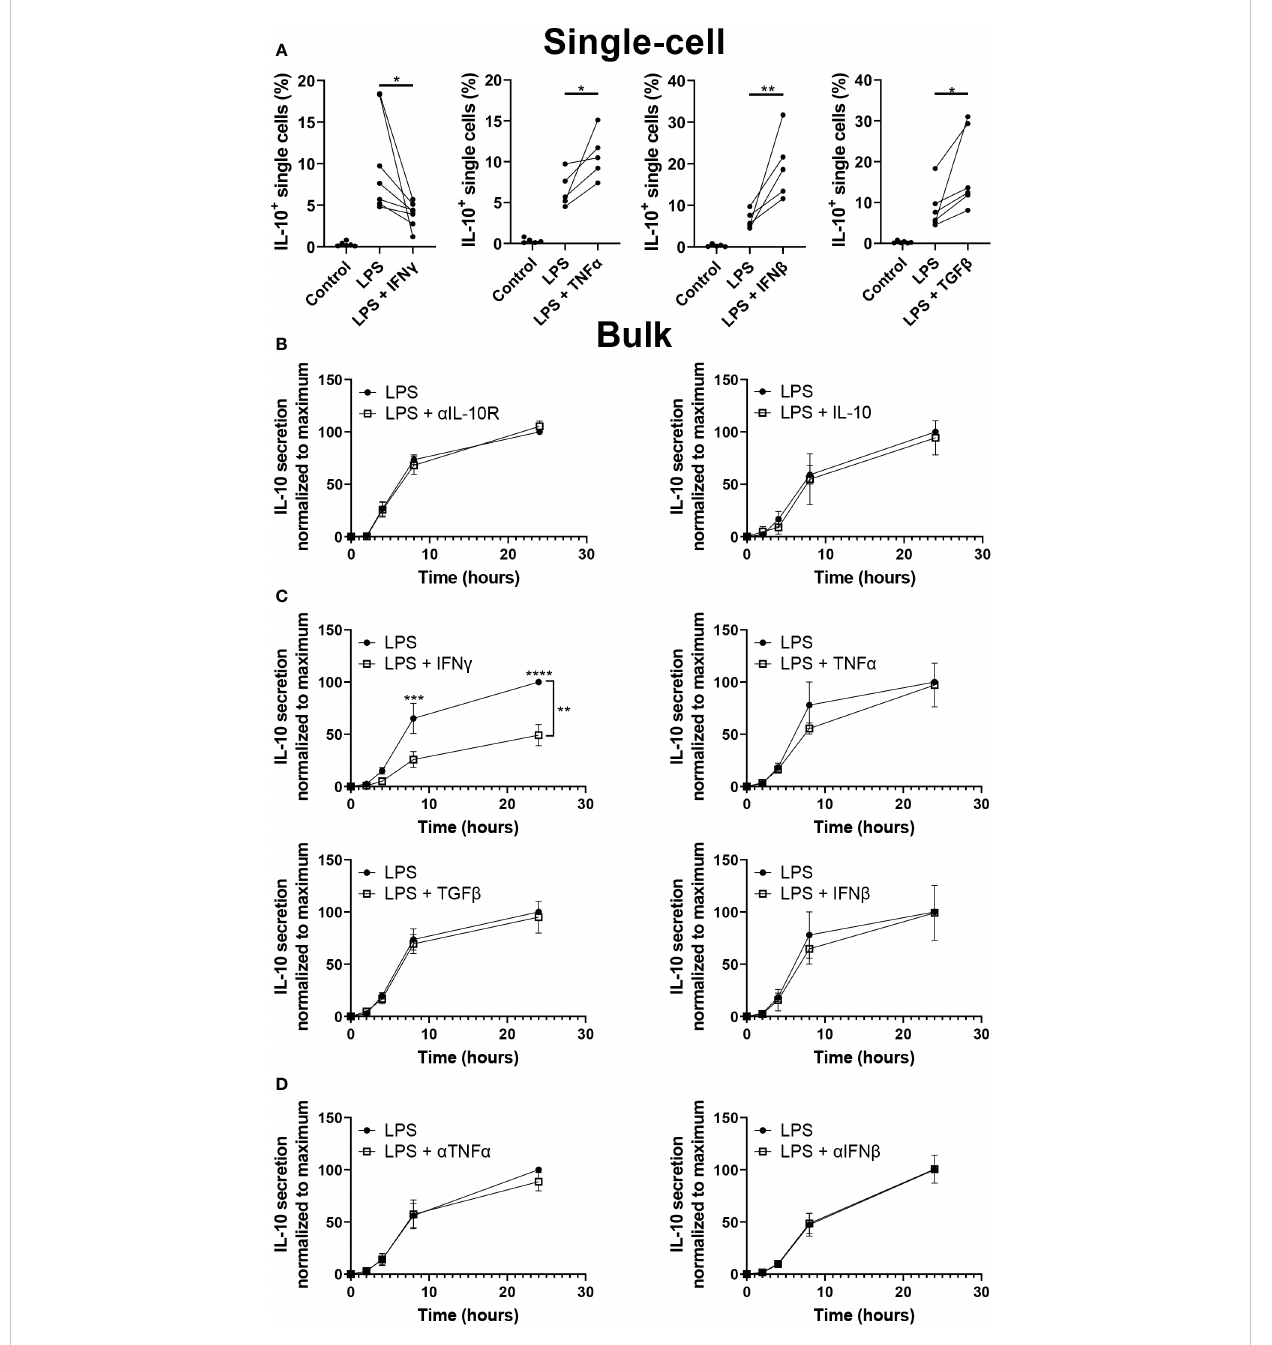
FIGURE 4 Effect of paracrine signals on IL-10 production. (A) Percentage of cells producing IL-10 after single-cell stimulation with LPS with or without IFNy (n=7), IFN b (n=5), TNF a (n =5) or TGF b (n=6). Signi fi cance was tested using One-way ANOVA and Tukey post hoc test. With * indicating p<0.05, and ** indicating p<0.01 (B) IL-10 quanti fi cation over 24h for bulk activated macrophages with and without IL-10R blocking antibodies (n=5 biological replicates) and with and without 100 pg IL-10 added 30 minutes prior to LPS activation. In the condition with IL-10 added, 100 pg of IL-10 was subtracted from fi nal readout (n=3 biological replicates). (C) IL-10 quanti fi cation over 24h for bulk activated macrophages with and without IFN g (n=5), TNF a (n=3), TGF b (n=6), or IFN b (n=3). Signi fi cance was tested using two-way RM ANOVA with ** indicating p< 0.01 for the variance attributed to treatment, and a post-hoc S ̌ ı ́ da ́ k test with *** indicating p<0.001 and **** indicating p<0.0001. (D) IL-10 quanti fi cation over 24h for bulk activated macrophages with and without neutralizing antibodies for TNF a (n=4) or IFN b